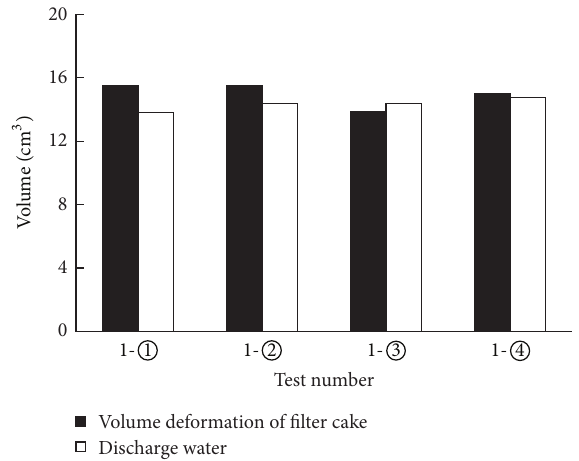
Figure 11: Comparison between the volume deformation and seepage discharge of filter